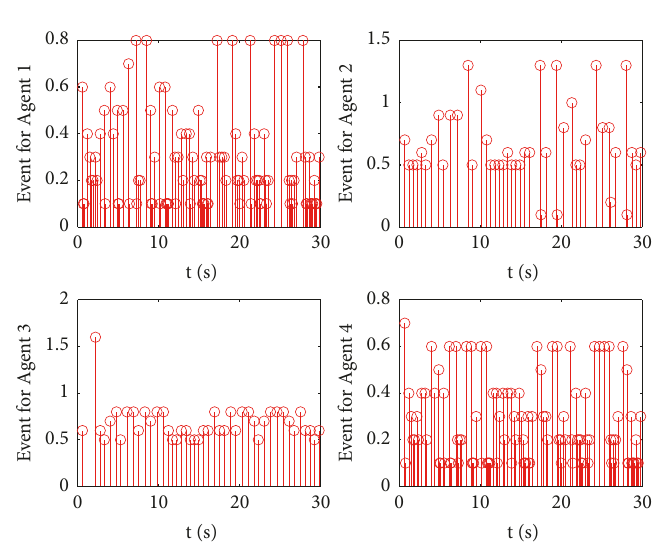
Figure 4: 𝑧 𝑖 (𝑡) and their estimation 𝑧 𝑓𝑖 (𝑡) .